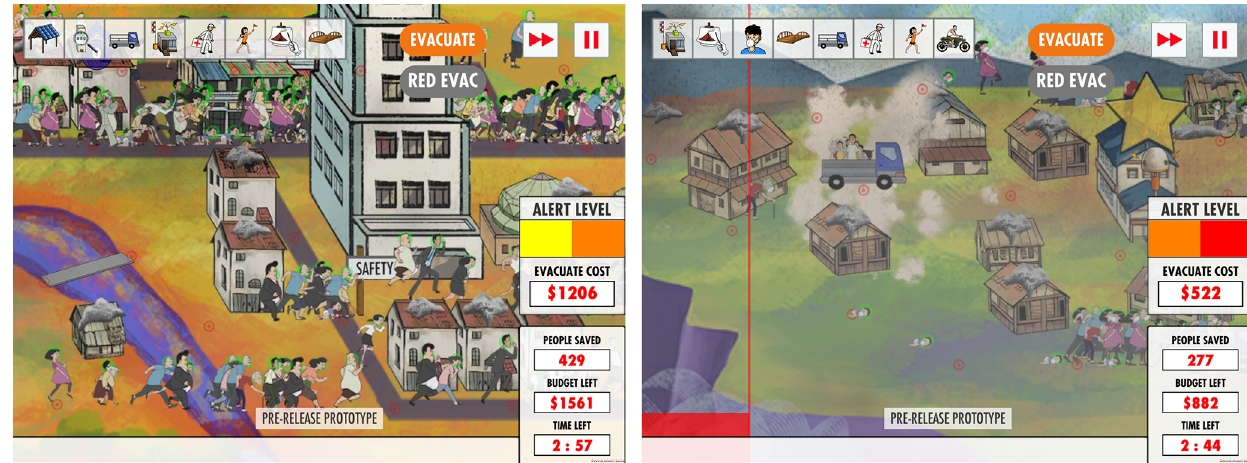
Figure 12. Quantitative data are displayed during action gameplay to help players assess their progress. Using the early warning displays the alert levels and the simplified hazard map.